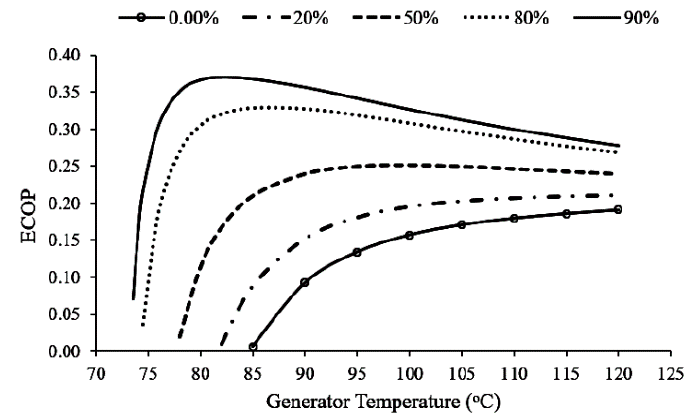
Figure 36. Variations of ECOPs with different ε SHX at different T gen .